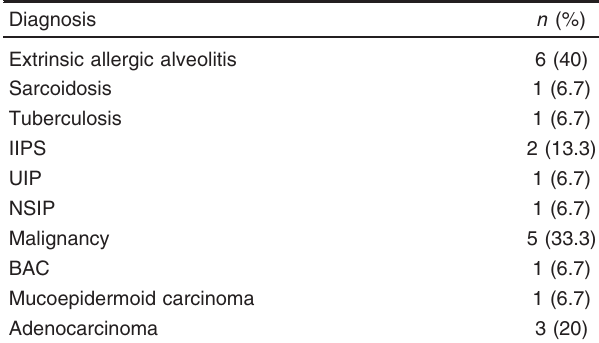
Table 4 Groups of final diagnosis obtained by VAMT lung